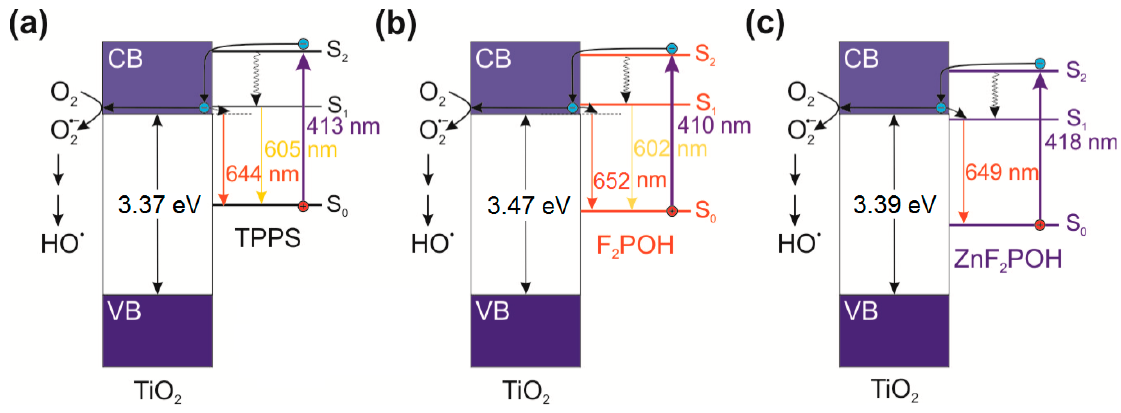
Figure 5. Proposed mechanism of the TiO 2 photosensitization, fluorescence emission, and possible pathway of hydroxyl radical generation after excitation of ( a ) TPPS@qTiO 2 , ( b ) F 2 POH@qTiO 2 , and ( c ) ZnF 2 POH@qTiO 2 . CB—conduction band; VB—valence band.